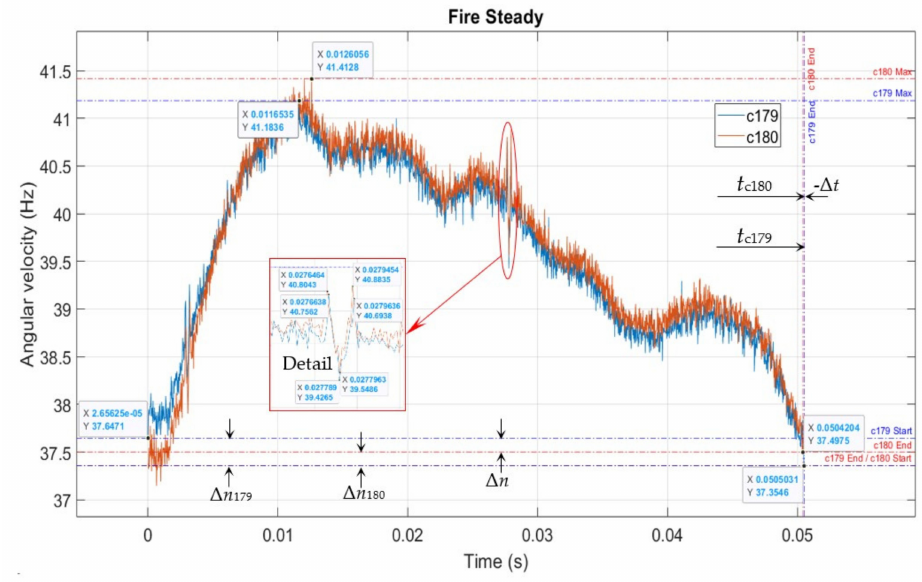
Figure 19. Cycles 179 and